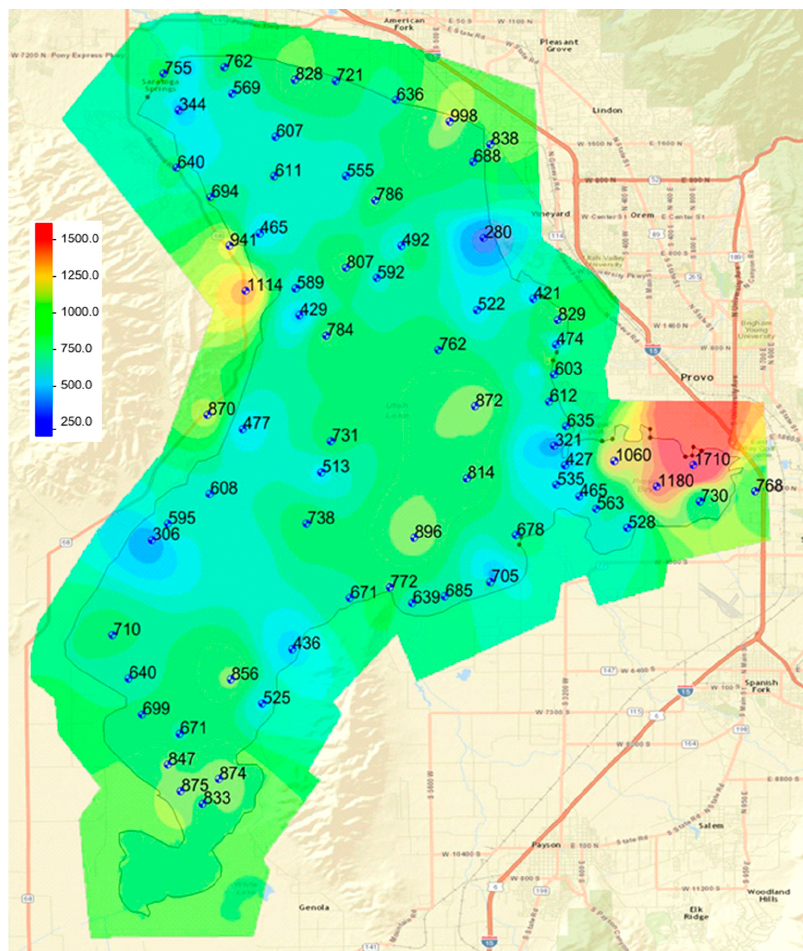
Figure 9. A geostatistical Model showing total phosphorous distribution in Utah Lake developed by interpolating among the sediment sample points inside the Lake as well as samples taken on the shore presenting historic lake sediments before any anthropogenic phosphorous sources. The colors represent the interpolated values, the numbers indicate total phosphorous concentrations at the sample points. Both the colors in the legend and the numerical values represent total phosphorous amounts in ppm, and the map is not to scale. This map shows that the total phosphorous distribution appears to be continuous from the current lake sediments to the historic sediments. This indicates that total phosphorous levels historically are similar to current values.